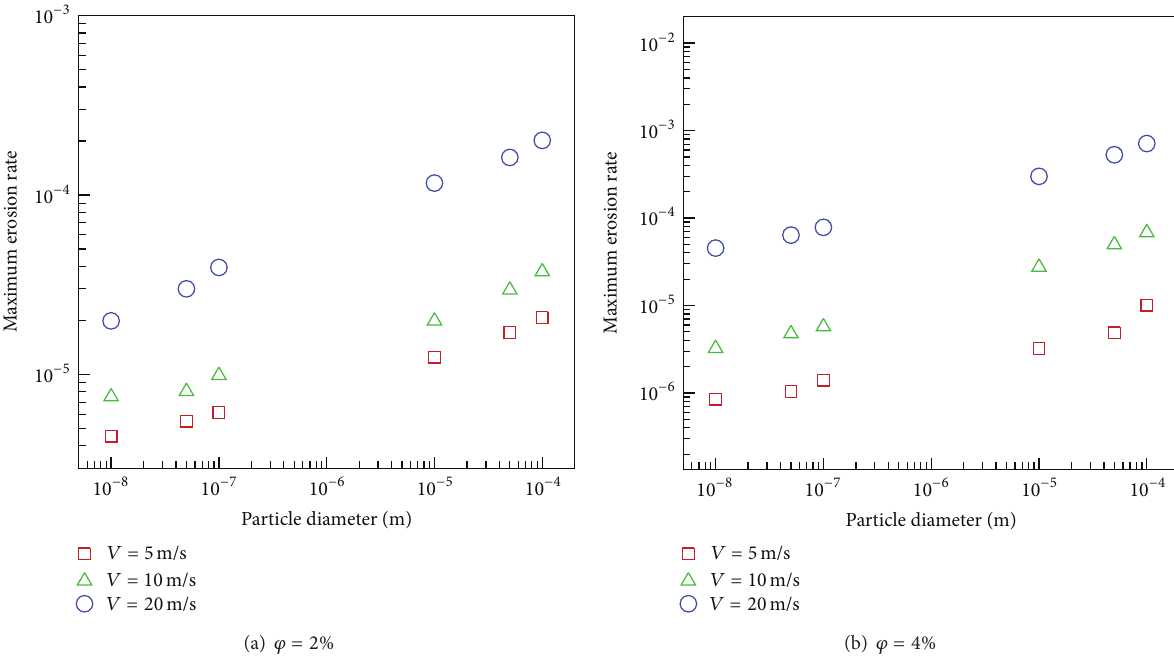
Figure 6: The variation of particle size with maximum erosion